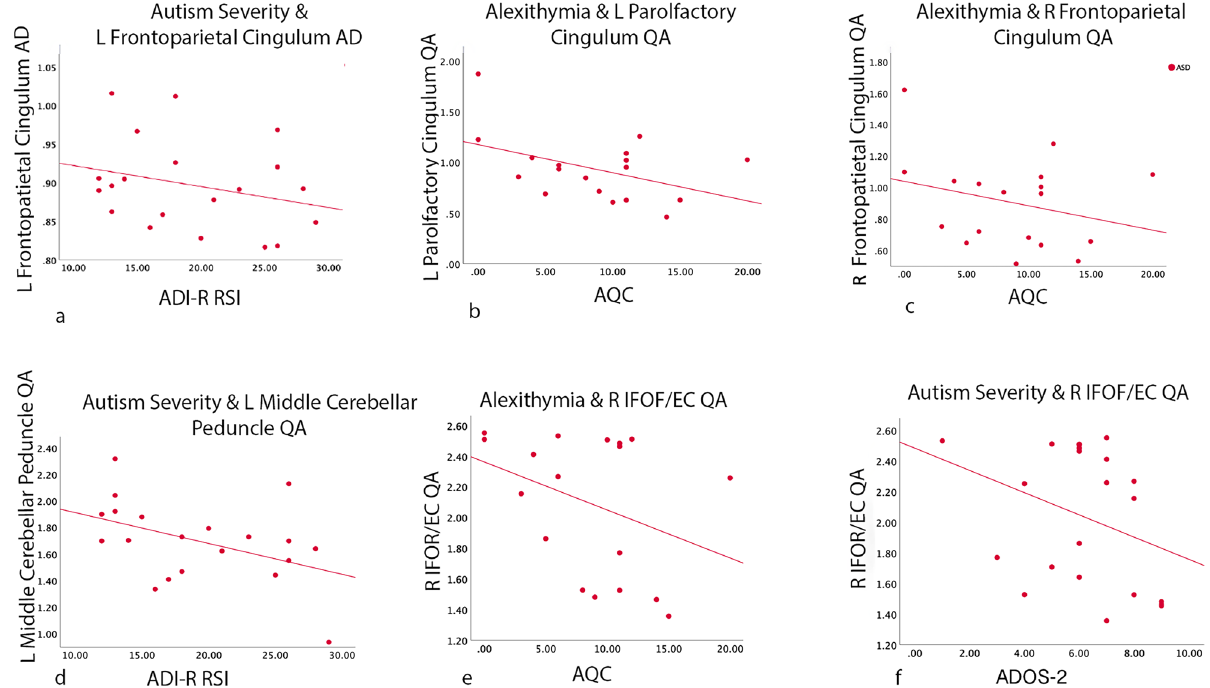
Figure 2. Relationship between diffusivity differences and autism severity or alexithymia. All correlations are within the ASD group and for TD > ASD contrasts. ( A ) Significant correlation between the left frontoparietal cingulum AD (TD > ASD contrast) and ADIR-RSI.; ( B ) Significant correlation between left parolfactory cingulum QA (TD > ASD contrast) and alexithymia (ACQ). ( C ) Significant correlation between right frontoparietal cingulum QA (TD > ASD contrast) and alexithymia. ( D ) Significant correlation between left middle cerebellar peduncle QA (TD > ASD contrast) and ADIR-RSI. ( E ) Significant correlation between right IFOF/EC QA (ASD > TD contrast) and alexithymia. ( F ) Significant correlation between right IFOF/EC QA (ASD > TD contrast) and ADOS-2 (autism severity). L = left; R = right; AQC = Autism Questionnaire for Children; ADIR-R RSI = Autism Diagnostic Interview Revised-Reciprocal Social Interactions; IFOF = inferior fronto-occipital fasciculus; EC = external commissure; TD = typically developing; ASD = autism spectrum disorder; DCD = developmental coordination disorder; QA = quantitative anisotropy; MD = mean diffusivity; AD = axial diffusivity, and RD = radial